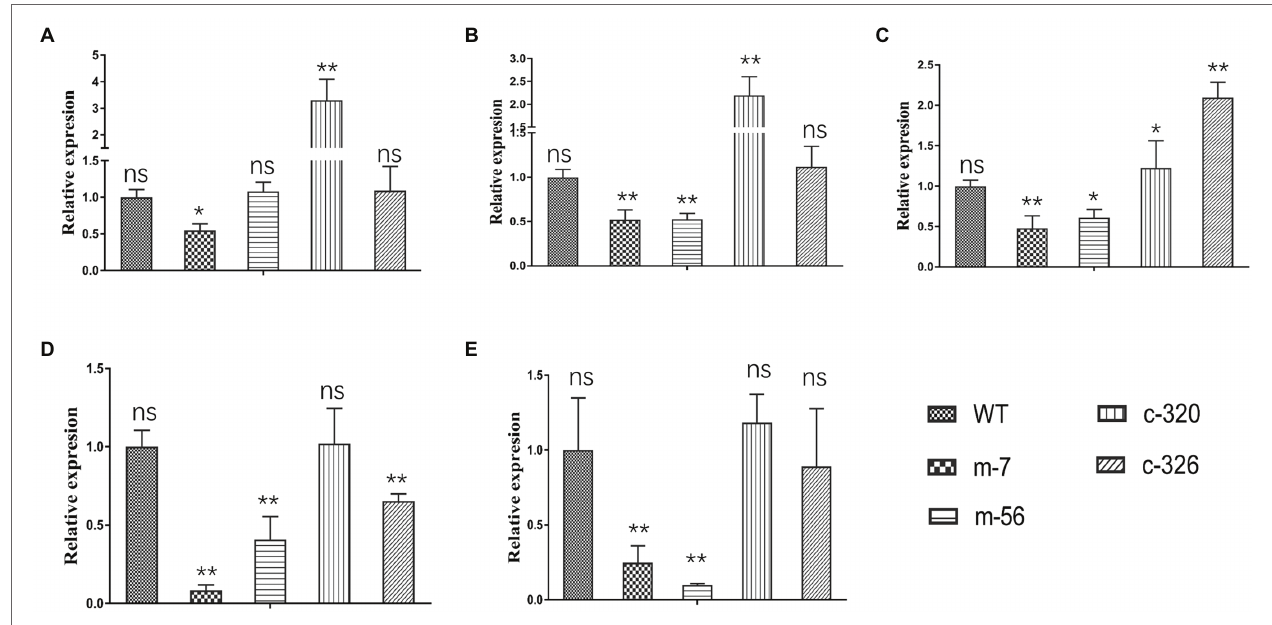
FIGURE 7 | RT–qPCR test of target genes controlled by VpxlnR. (A) Salicylate hydroxylase encoding gene (VP1G_09520), (B) serine/threonine-protein kinase encoding gene (VP1G_03128), (C) alpha-xylosidase encoding gene (VP1G_06369), (D) G-protein beta subunit encoding gene (VP1G_02856), and (E) Acid phosphatase encoding gene (VP1G_03782). The transcript level of each gene was normalized to actin expression. Each test was repeated three times, and the statistical analysis was performed using one-way ANOVA. ns indicates a value of p > 0.05, * indicates a value of p < 0.05, and ** indicates a value of p <